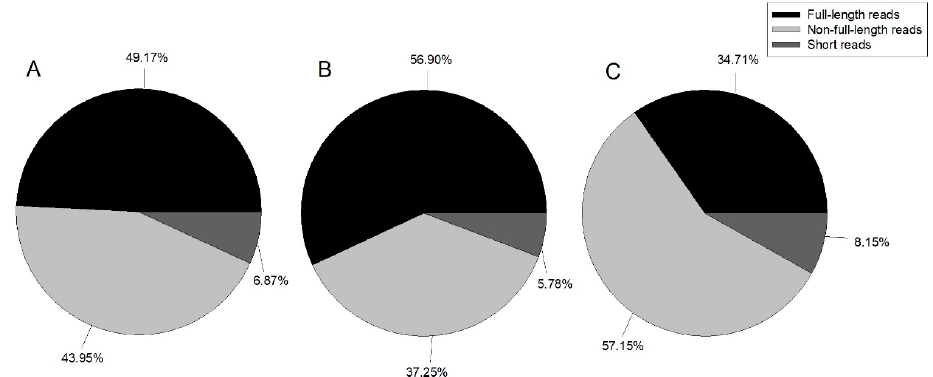
Figure 1. Pie chart of ROI (reads of inserts) classification summary. A: 1–2 kb, B: 2–3 kb, and C: 3–6 kb.